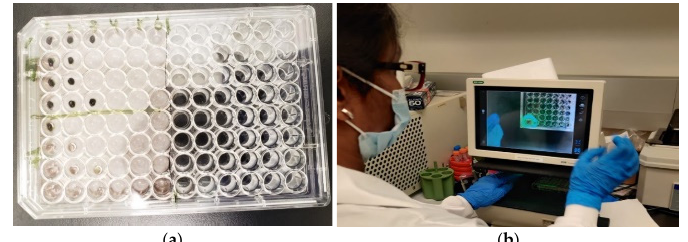
Figure 4. Betacoronavirus 1 was plated in a 96 ‐ well plate and incubated for 16–24 h. An inverted microscope was used to count the number of wells with and without CPE, followed by calculating the TCID50 using the Reed–Muench method: ( a ) performing TCID50 on host cells in a 96 ‐ well plate; ( b ) using an inverted microscope to count the number of wells with and without CPE.